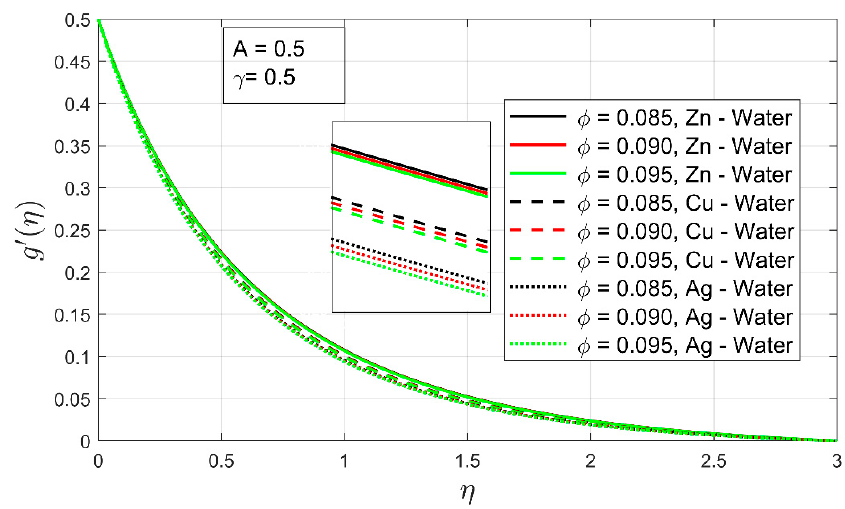
Figure 6. The influence of volume concentration φ on the velocity profile g (cid:48) ( η )